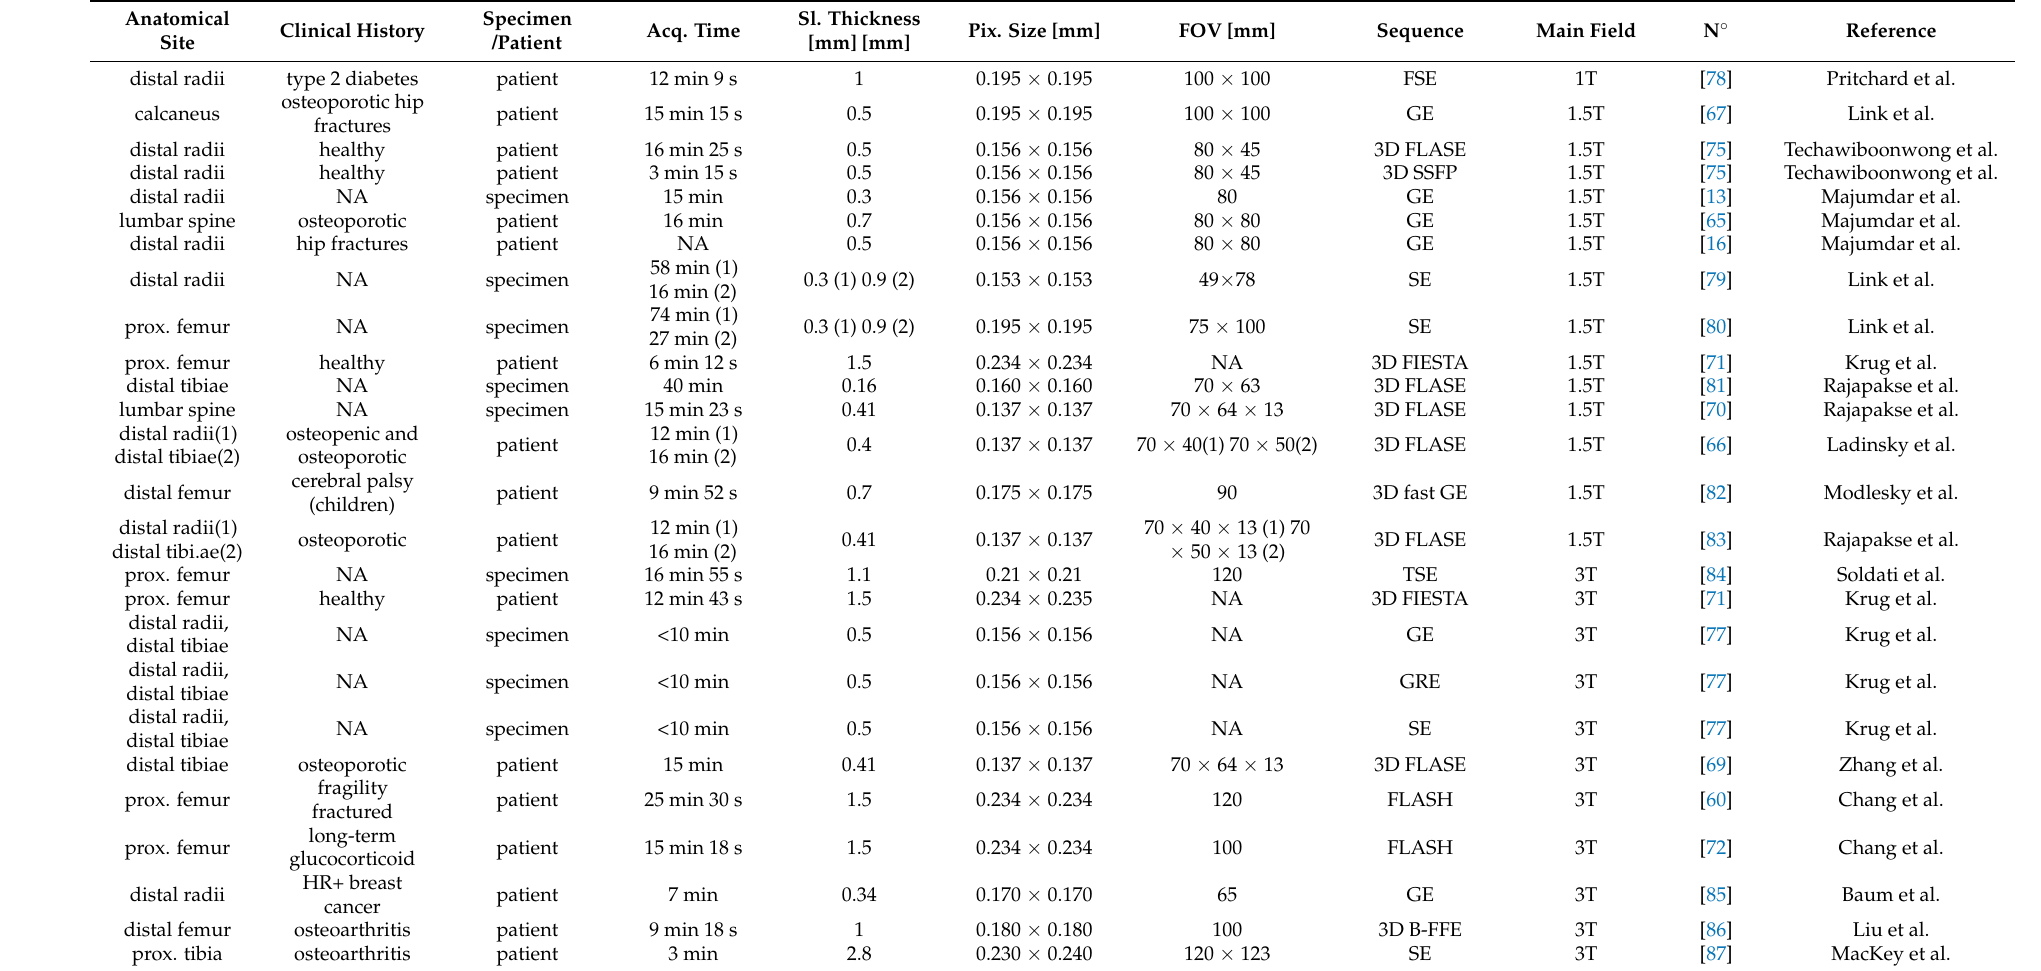
Table 1. List of the main magnetic resonance imaging (MRI) parameters and